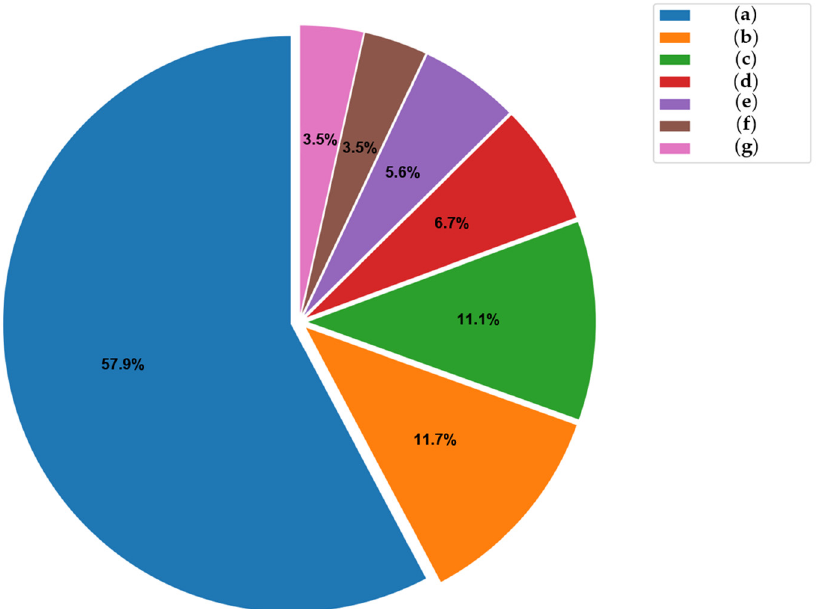
Figure 8. User preference results of our method and six state-of-the-art methods: ( a ) Our method; ( b ) SANet [22]; ( c ) STROTSS [2]; ( d ) AdaIN [5]; ( e ) WCT [6]; ( f ) Gatys et al. [1]; ( g ) Johnson et al. [3].